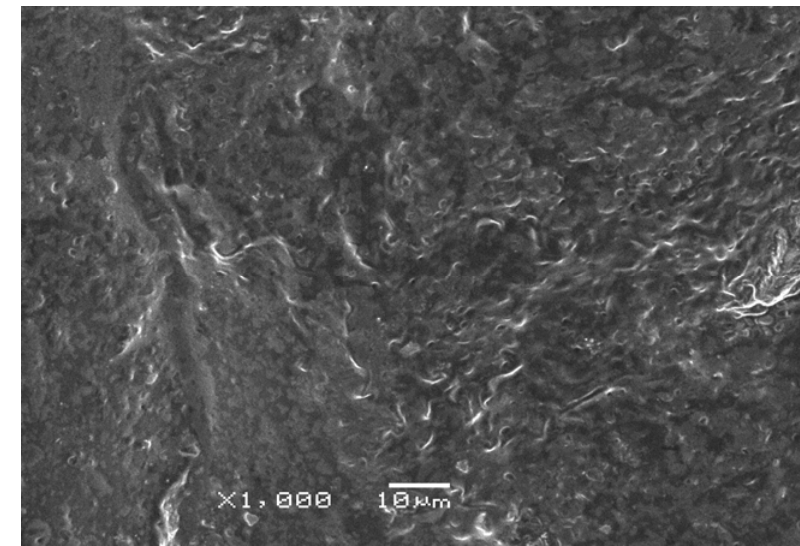
Figure 3. Scanning electron micrograph of